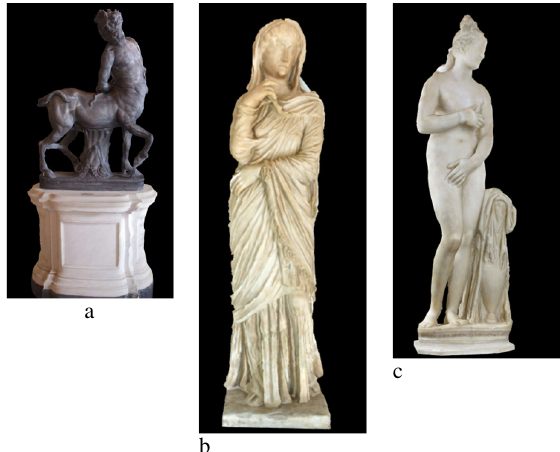
Figure 5. Three examples of 3D models obtained: (a) the old centaur; (b) a female statue; (c) the Capitoline Venus.